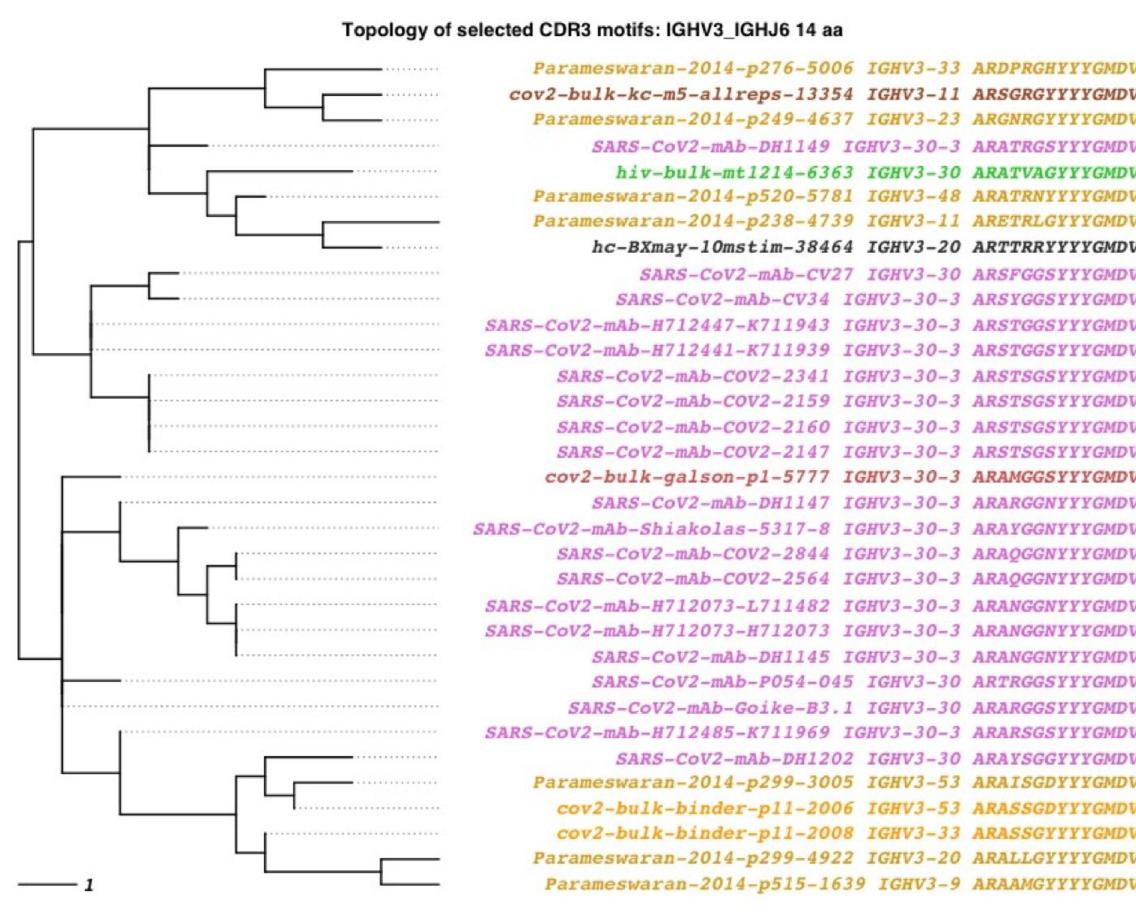
Fig 8. SARS-CoV-2, HIV-1, & dengue convergent clonotypes to anti-SARS-CoV-2 mAb DH1149 in the 3_6_14 bin. An 80% identity threshold is used to calculate convergence. Tips are colored by dataset source. Purple tips are published anti-COVID-19 antibodies from 7 different studies, dark gray tips are antibody sequences from a healthy donor BCR repertoire, and orange through brown shaded tips are antibody sequences from COVID-19 patient BCR repertoires. Green shaded tips are antibody sequences from HIV-1 patient BCR repertoires. Gold tips are antibody sequences from a cohort of Nicaraguan dengue patient BCR